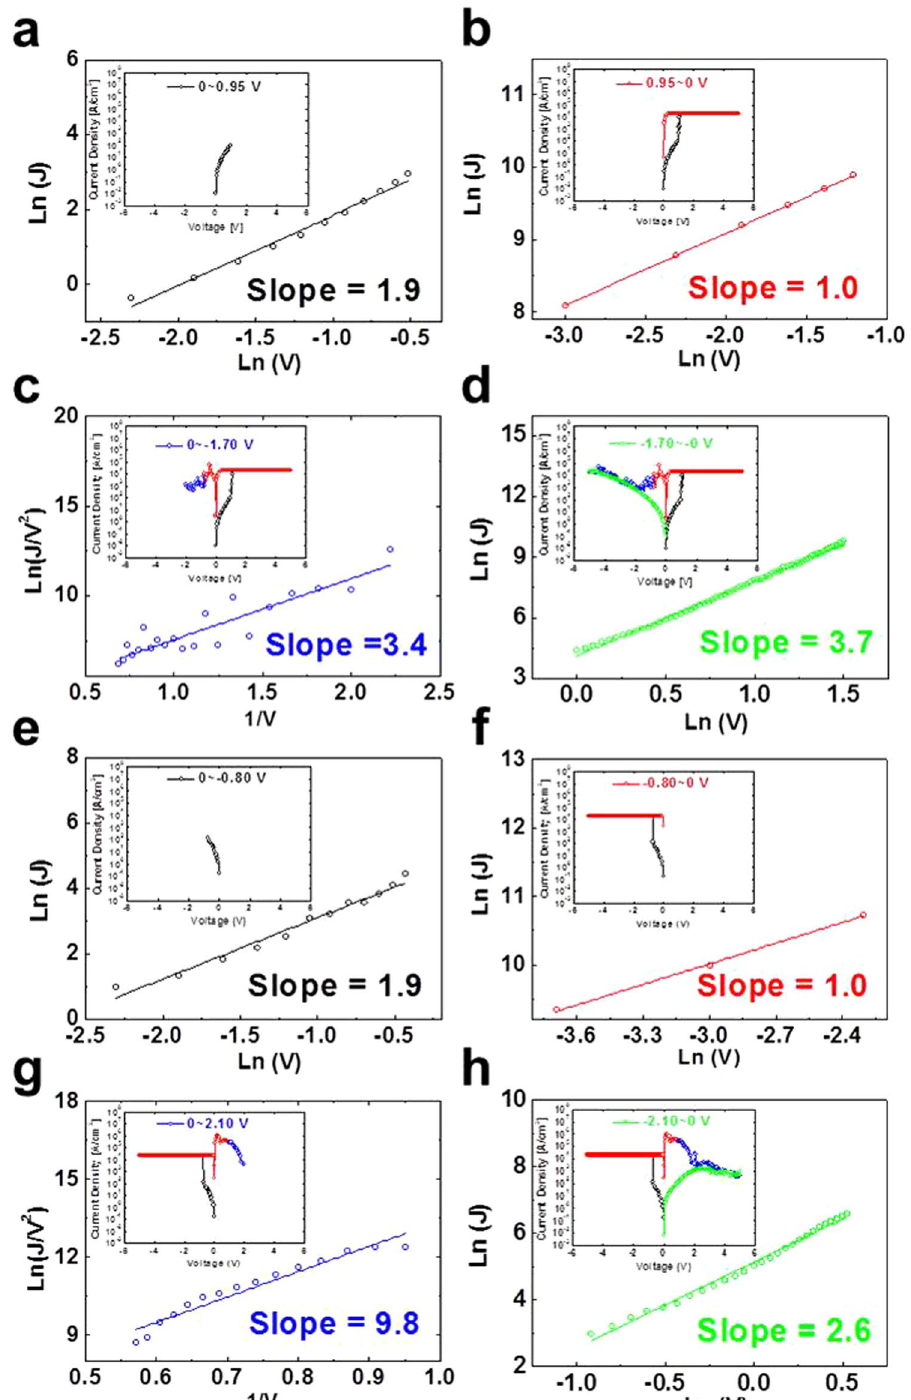
Figure 6. Current conduction mechanism for Ag-doped PEO polymer-electrolyte based CBRAM cell. For electro-forming at a positive applied bias on Pt cathode: ( a ) HRS between 0 and V set ( + 0.95 V), ( b ) V set ( + 0.95 V) and 0 V, ( c ) NDR, and ( d ) V reset ( − 1.70 V) and 0 V. For electro-forming at a negative applied bias on Pt cathode: ( e ) HRS between 0 and V set ( − 0.80 V), ( f ) V set ( − 0.80 V) and 0 V, ( g ) NDR, and ( h ) V reset ( − 2.10 V) and 0